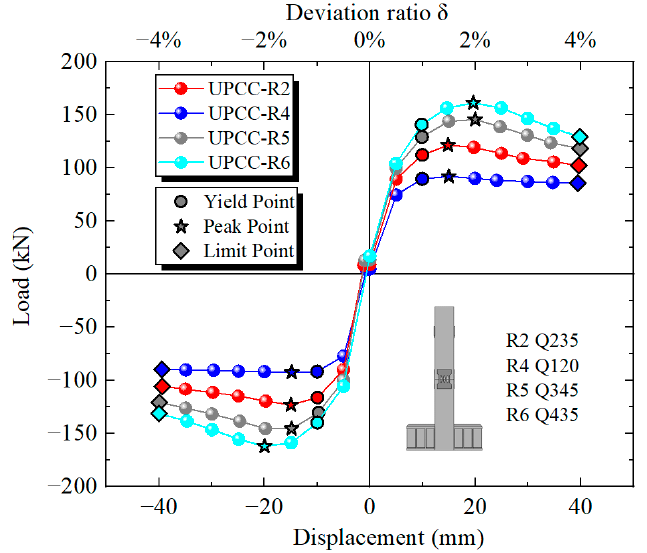
Figure 24. Skeleton curves under different steel yield strength of EREDL.